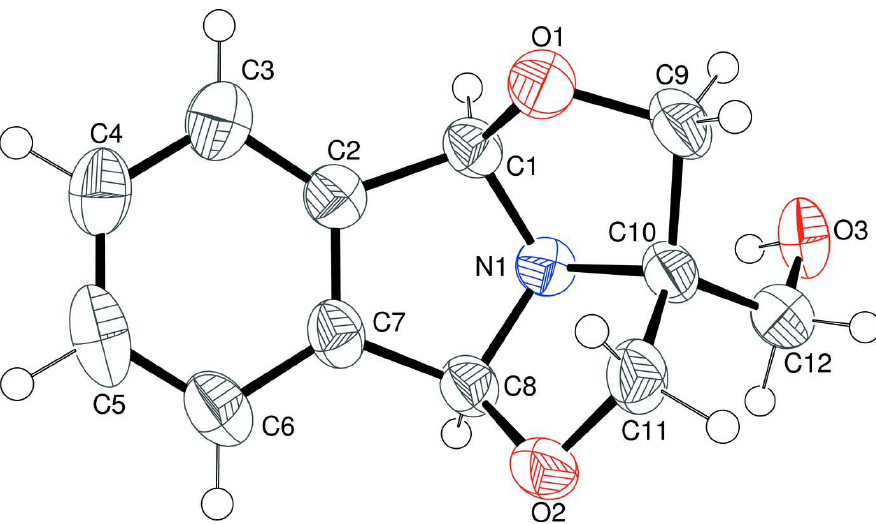
Figure 1 The molecular structure of (I) showing 50% displacement ellipsoids for the non-hydrogen atoms. Only one orientation of the disordered -CH OH group is 2